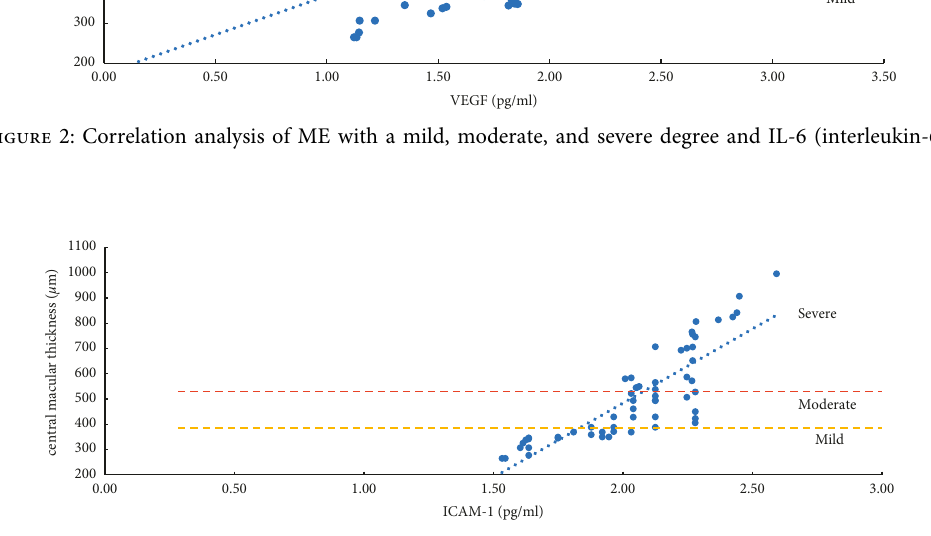
Figure 3: Correlation analysis of ME with a mild, moderate, and severe degree and ICAM-1 (intercellular adhesion molecule-1).